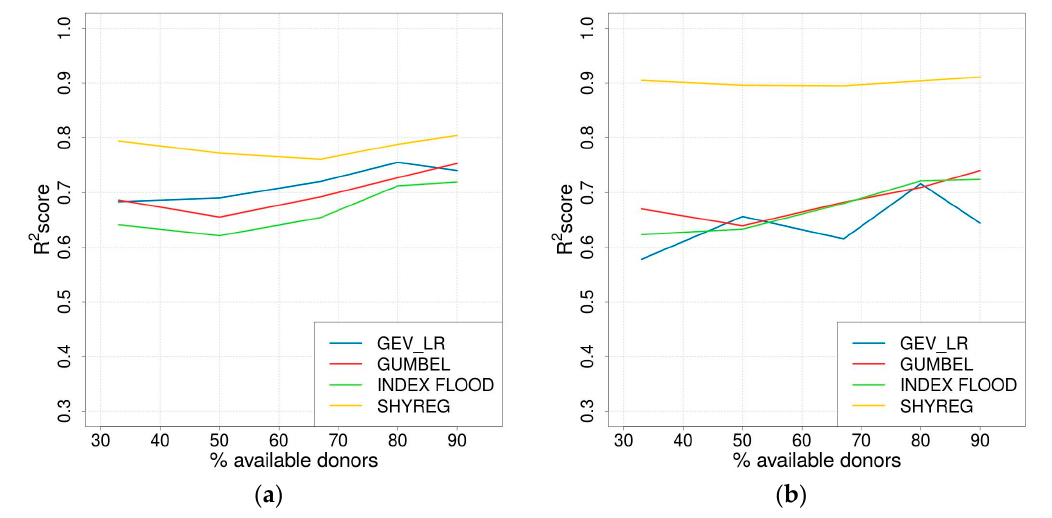
Figure 6. R 2 criterion for the different regionalised FFAs with varying numbers of donor catchments. ( a ) 10-year quantile; ( b ) 100-year quantile.